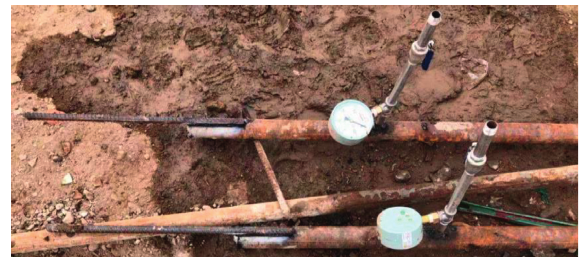
Figure 9: Threaded steel bar